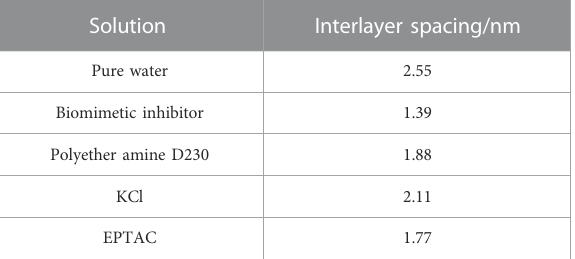
TABLE 5 Interlayer spacing of montmorillonite soaked in different solutions (3%